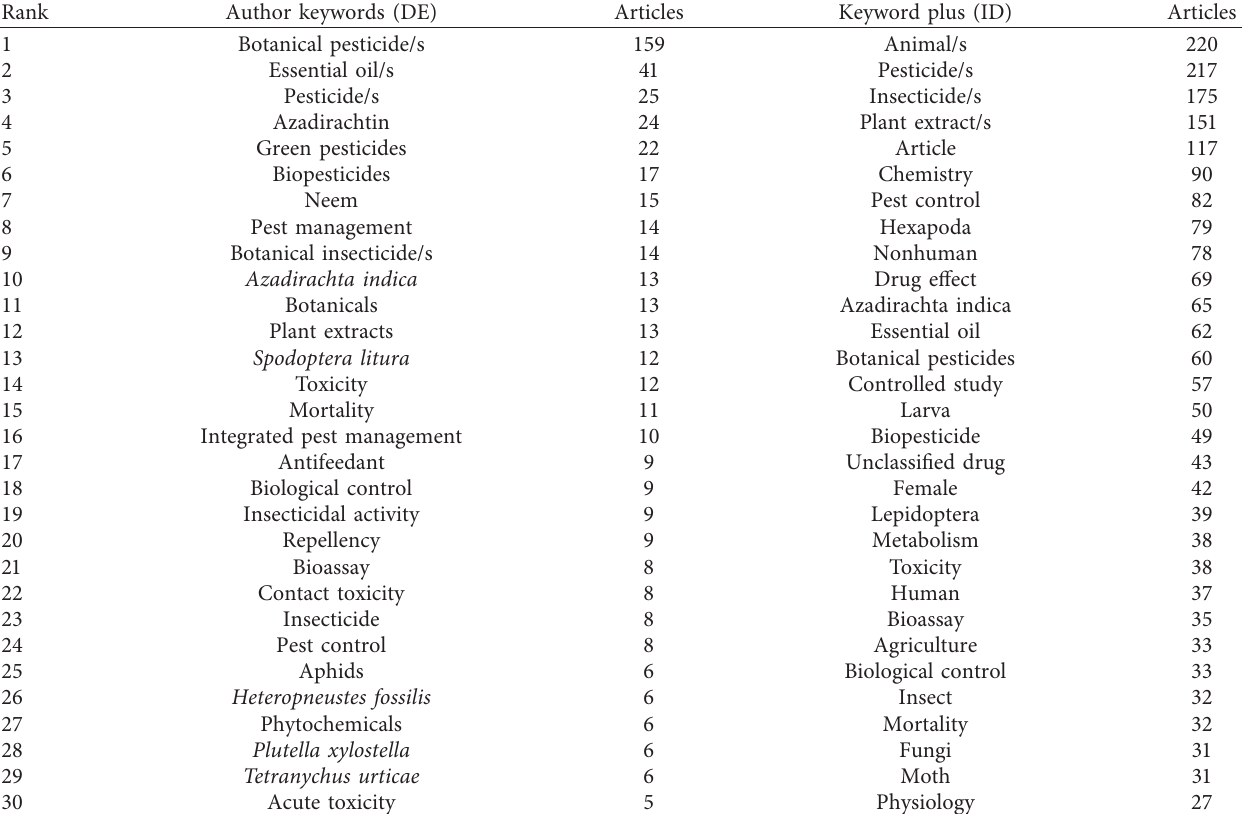
Figure 1: Annual scientific publications of documents on plant biopesticides from 1994 to 2019 in the Scopus database. Table 2: Top 30 most relevant keywords on green pesticide research from 1994 to